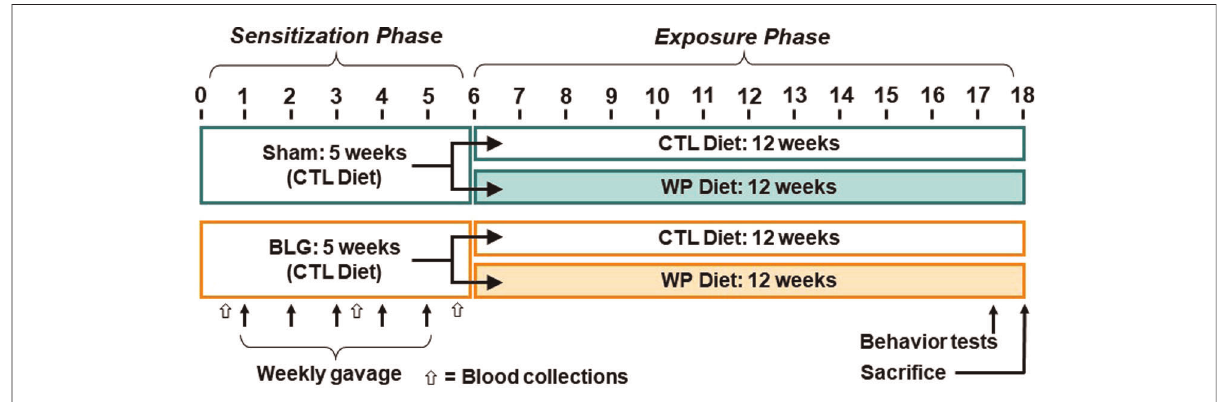
FIGURE 1 Experimental timeline. Four-week-old male C57BL/6J mice were subjected to a 5-week sensitization regimen. Starting at Week 1, the BLG sensitization groups received weekly oral administration of 1 mg BLG in 200 μ l of bicarbonate buffer with 10 µg cholera toxin as an adjuvant, while the sham groups received only the adjuvant in the buffer (arrows). Upon completion of the sensitization phase, mice were placed on either a whey-free control (CTL) or 0.3% whey protein (WP) diet from Week 6 for additional 12 weeks. During the last week of the exposure phase, behavior tests were performed. The numbers indicate experimental weeks. The black, thin arrows indicate the timing of 5 weekly gavages, and the open arrows indicate the timing of blood